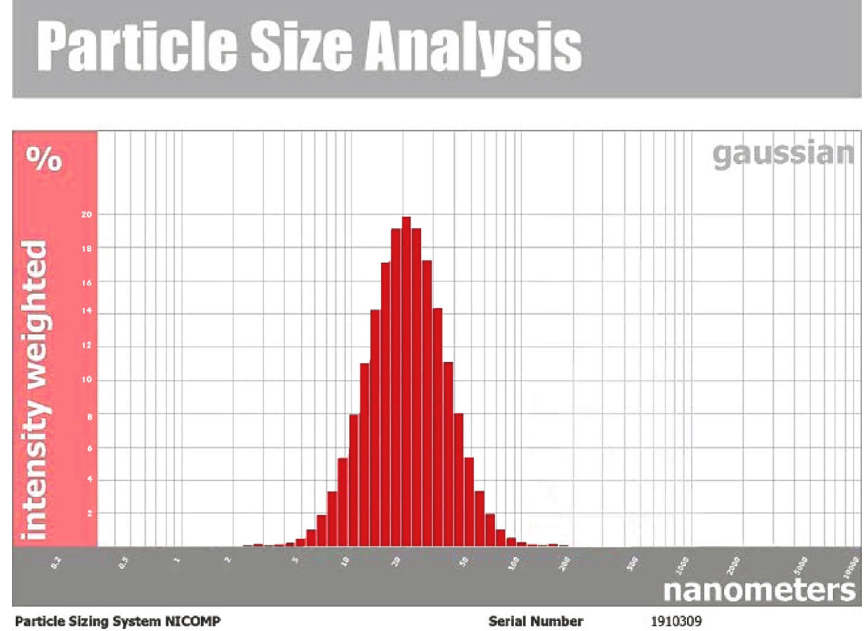
Figure 3: The average particle size of the synthesized AgNPs of vanillic acid was 21.6nm as appeared by DLS spectrum